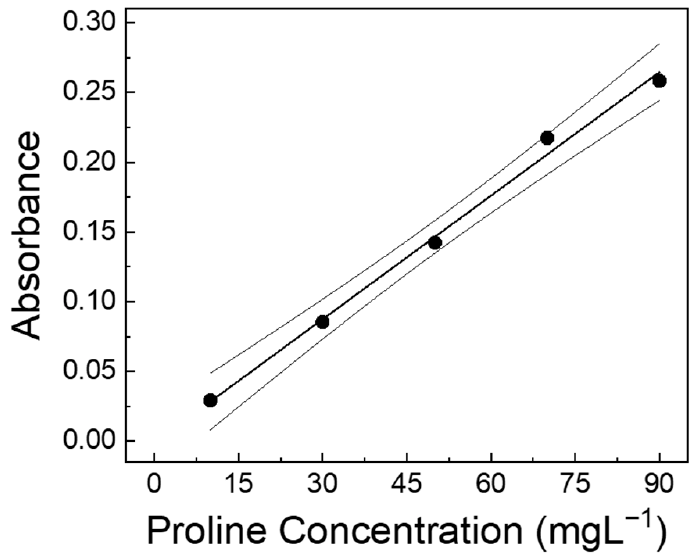
Figure 4. Straight-line spectrophotometric calibration curve built for proline measurements in real samples (wines), using ninhydrin spectrophotometric format.